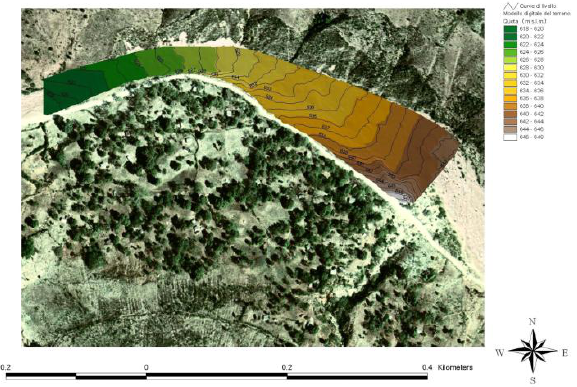
Figure 9. Example of a DEM derived from the GNSS high detailed survey